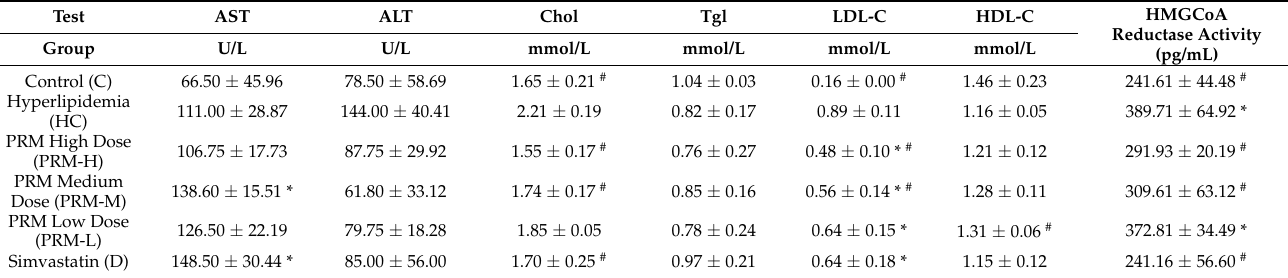
Table 2. Serum biochemistry and hydroxymethylglutaryl CoA (HMGCoA) reductase activity for control, polyphenol-rich mixture (PRM) treated rats and drug